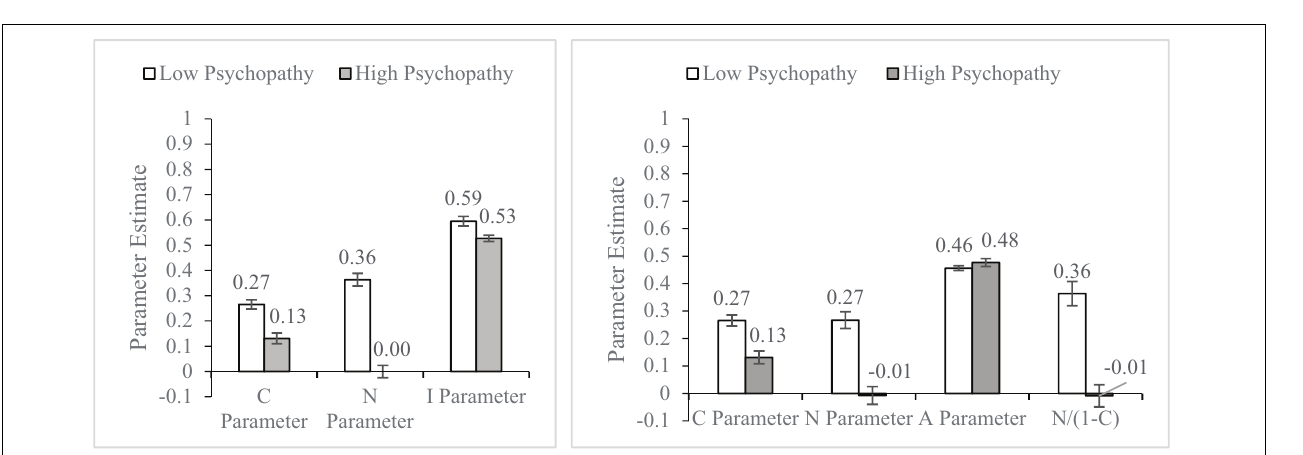
Frontiers in Psychology |